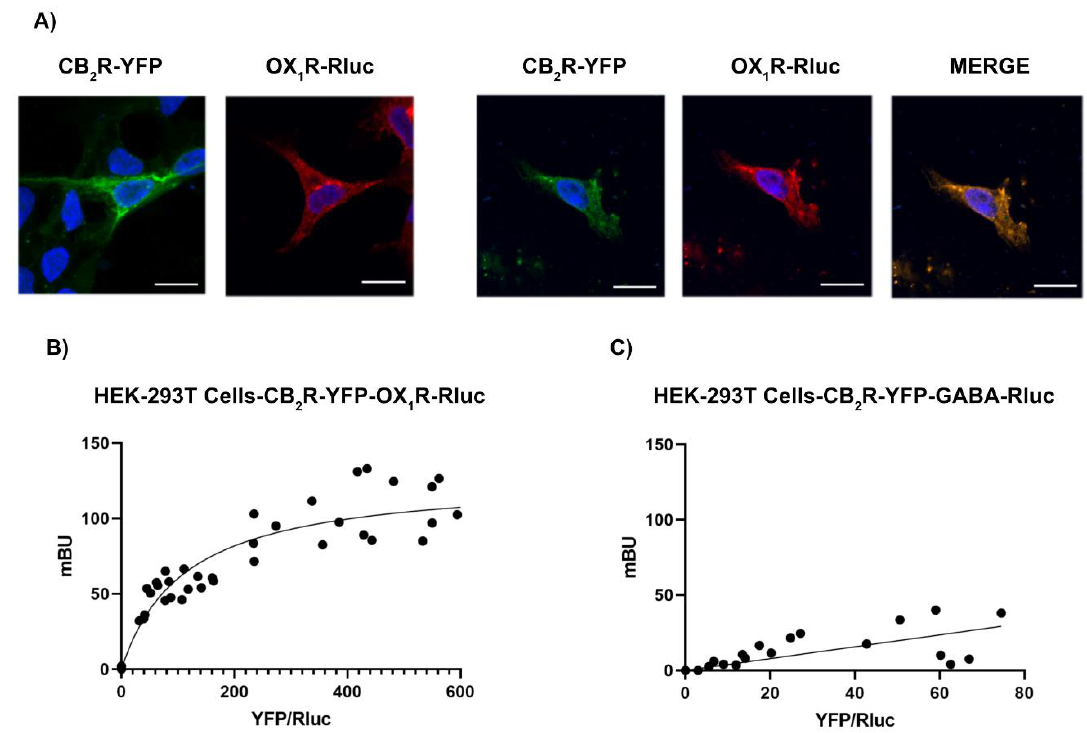
Figure 1. The OX 1 R and CB 2 R interact in a heterologous expression system. ( A ) Immunocytochem- istry assays were performed in HEK-293T cells expressing CB 2 R- YFP (1 μg cDNA), which was de- tected by its own fluorescence (green) and/or OX 1 R- Rluc (1 μg cDNA) that was detected by a mouse monoclonal anti-Rluc antibody and a secondary Cy3-conjugated anti-mouse IgG antibody (red).